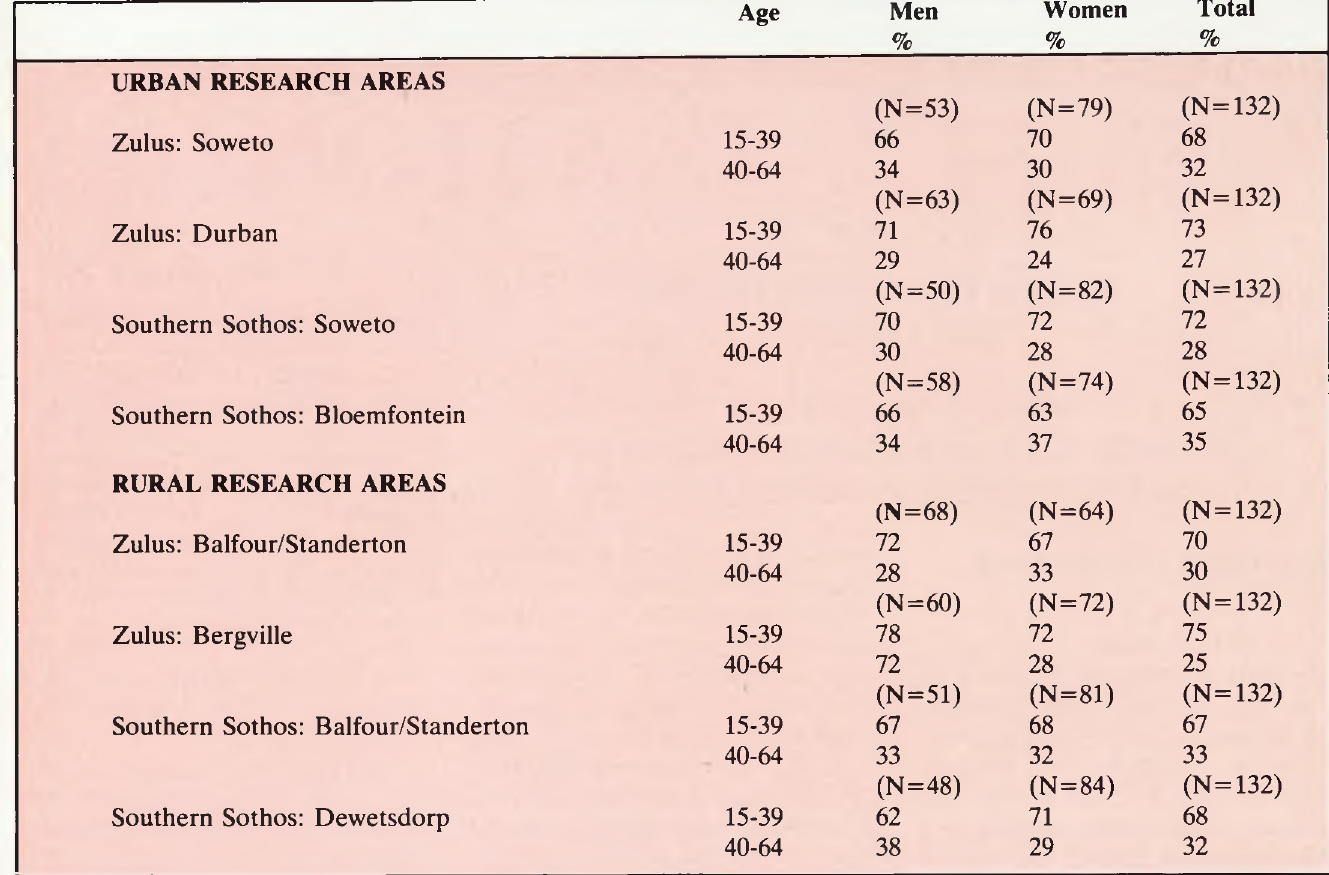
Table 1 Composition of the samples according to research area, age and sex